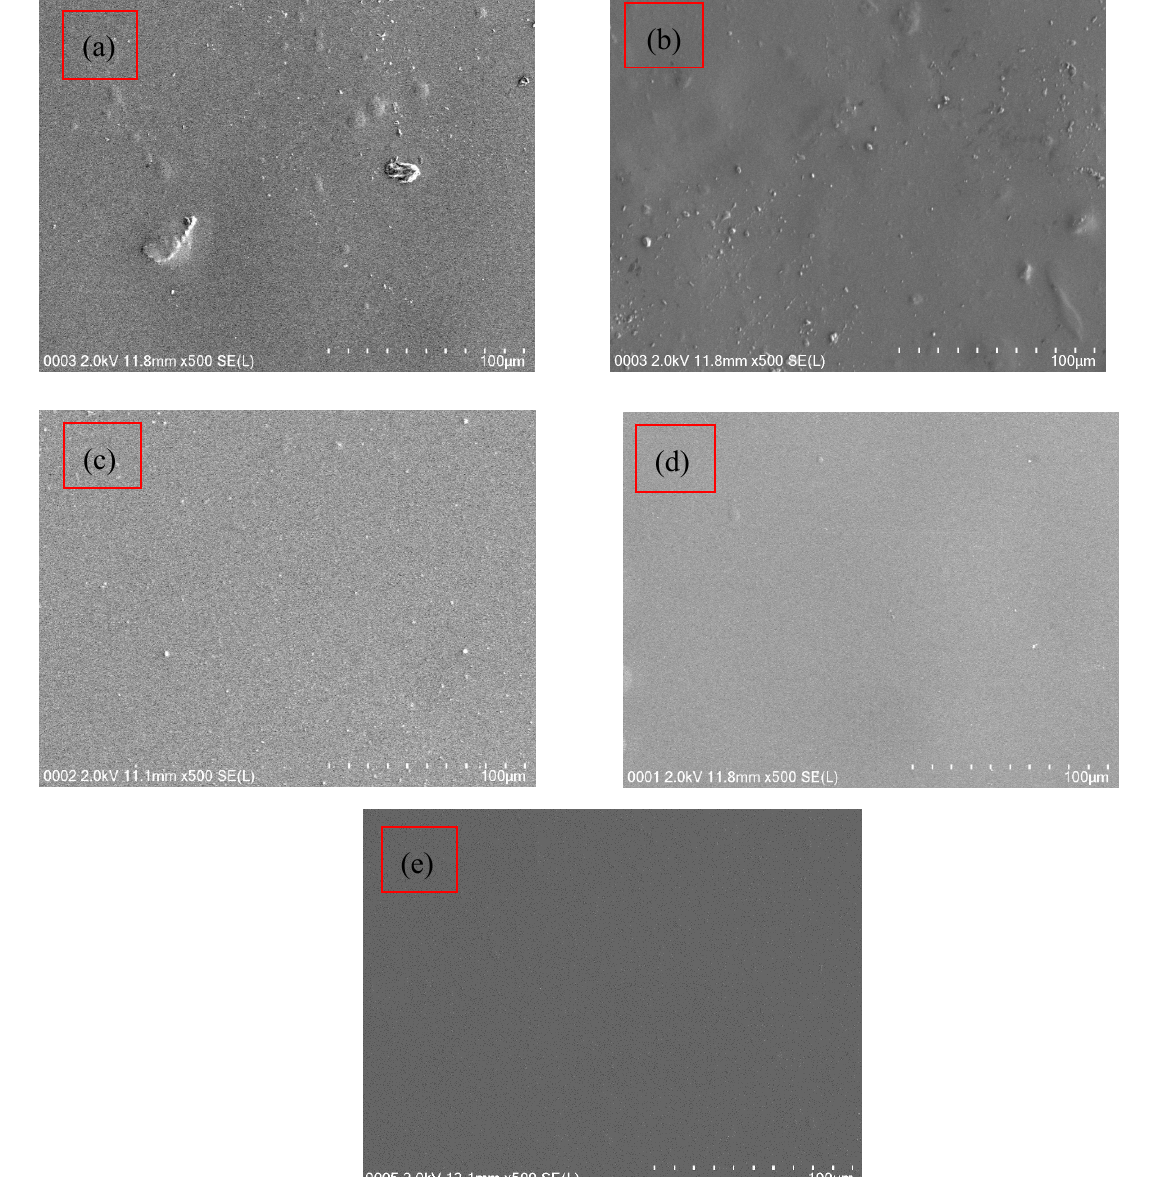
Figure 3. FESEM images for ( a ) PNCG-1, ( b ) PNCG-2, ( c ) PNCG-3, ( d ) PNCG-4, and ( e ) pure PVA film.